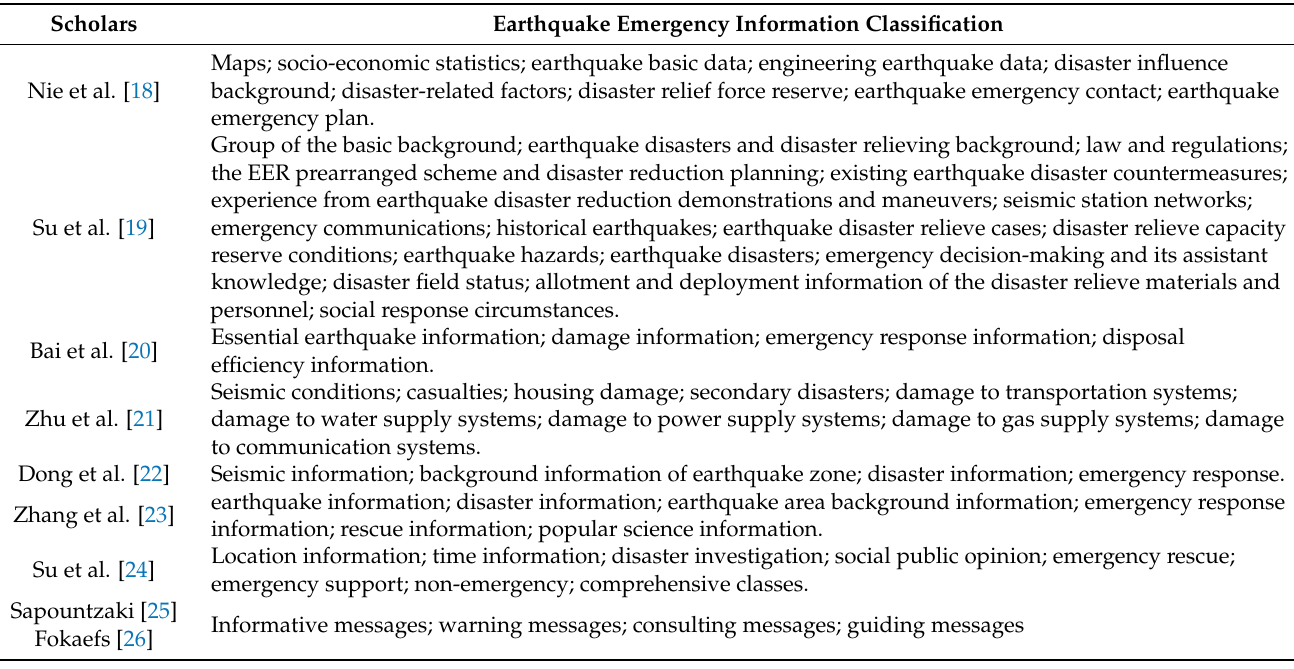
Table 1. Earthquake emergency disaster information